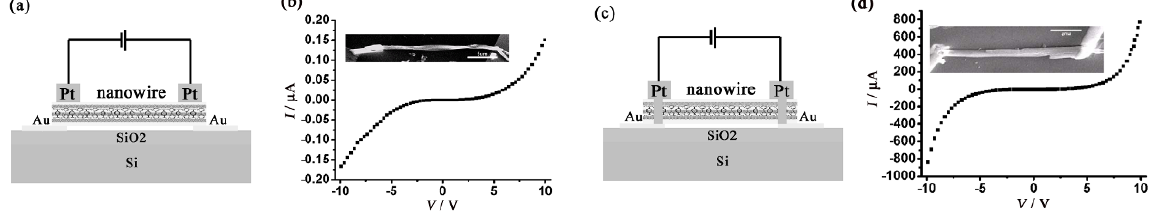
Figure 5. (a) Schematic diagram of the device with contacts made on the side wall of the TTF • TCNQ helical nanowire and (b) the I − V characteristic of the corresponding nanowire in (a). (c) Schematic diagram of the device with contacts made on the ends of the TTF • TCNQ helical nanowire (open ends were milled with focused ion beam) and (d) the I − V characteristic of the corresponding nanowire in (c). [Reproduced with permission